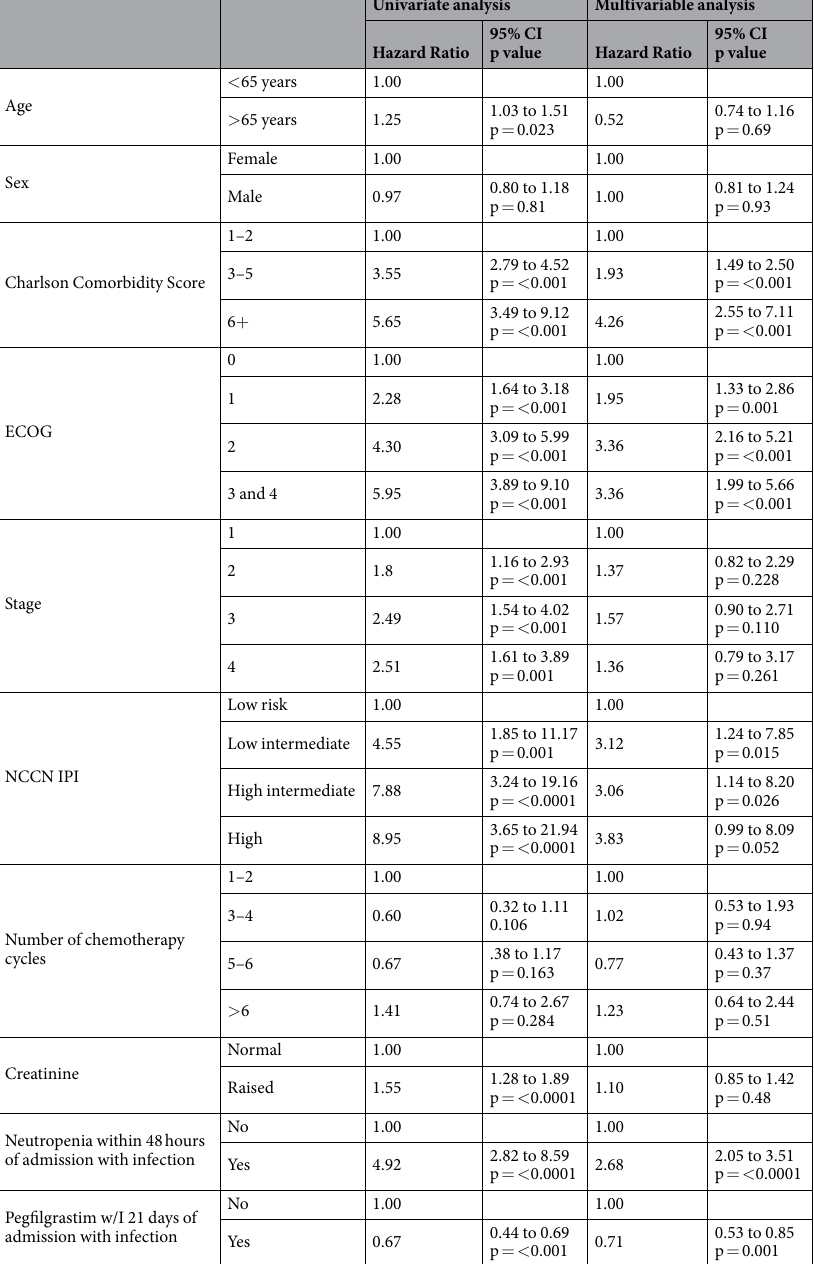
Table 5. Regression analysis of the factors associated with infection in patients who received R-CHOP 21 (n = 286). ECOG = Eastern Cooperative Oncology Group performance status point scale. NCCN- IPI = International Prognostic